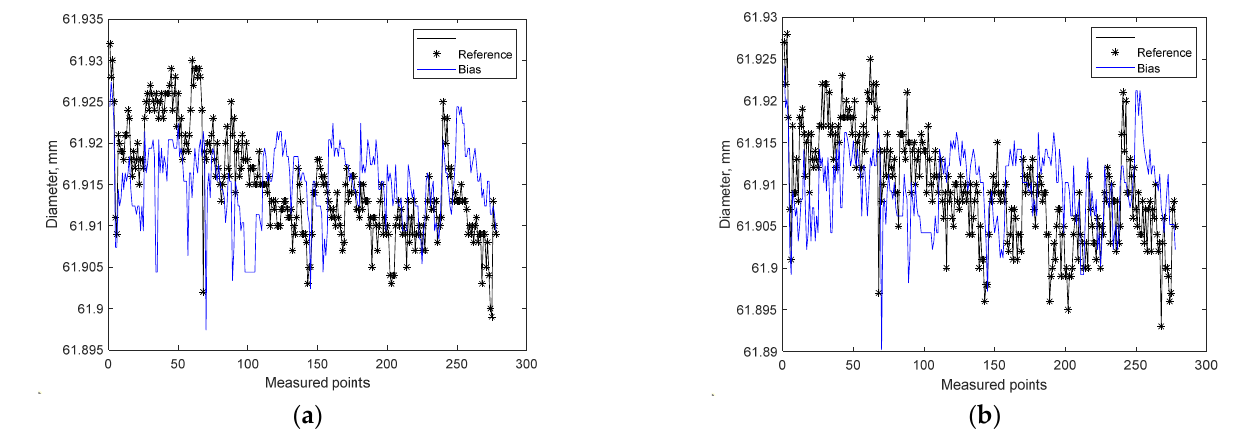
Figure 6. Results of estimation with the use of a model with bias: ( a ) measurement at point A on the workpiece: D stabilized = − 0.0086 + D heated ; ( b ) measurement at point B on the workpiece: D stabilized = − 0.0088 + D heated .